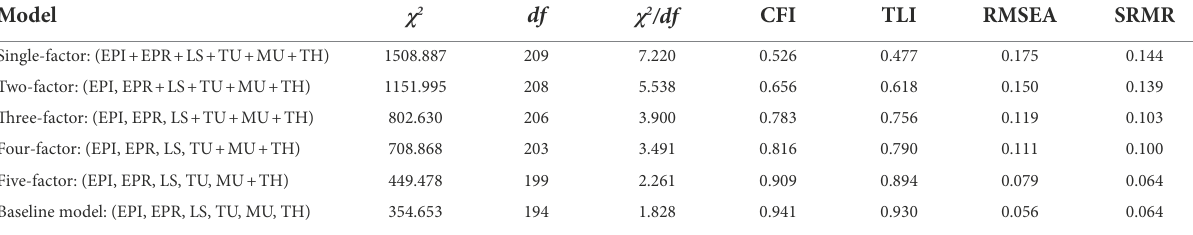
TABLE 4 The CFA results for the structural model.